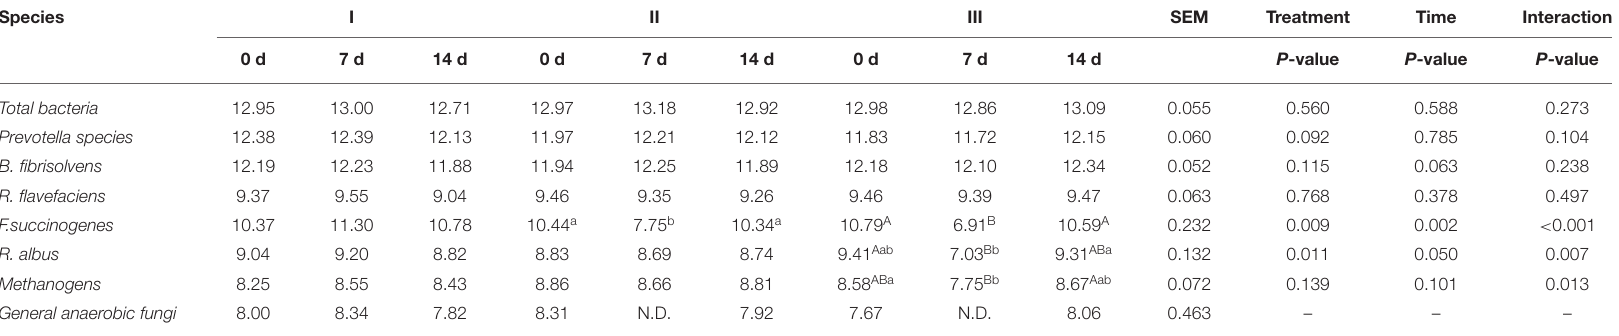
TABLE 2 | Log copies of a target microorganism in rumen fluid of lambs (Multiple comparisons between treatment at a specific time). Species